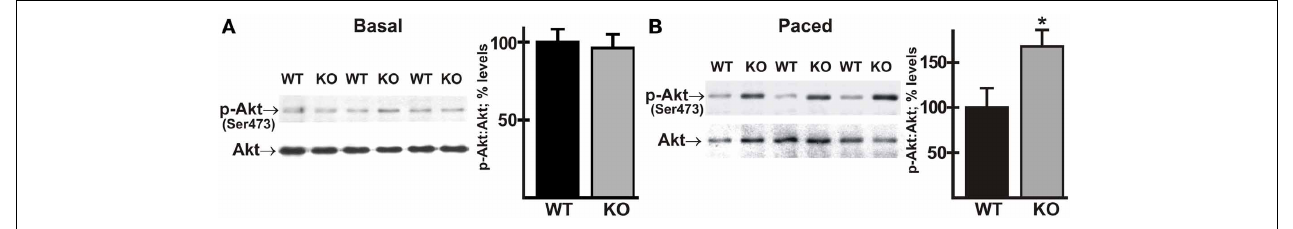
levels of: (A) total Akt and phosphorylated Akt (Ser473) under basal conditions; and (B) total Akt and phosphorylated Akt (Ser473) during pacing at 550bpm. Results show representative immunoblot and percent relative levels (normalized to total Akt levels) of phosphorylated Akt. Values shown are means ± SE, n = at least 10 for each genotype and pacing condition. ∗ p < 0 . 05 vs. WT.